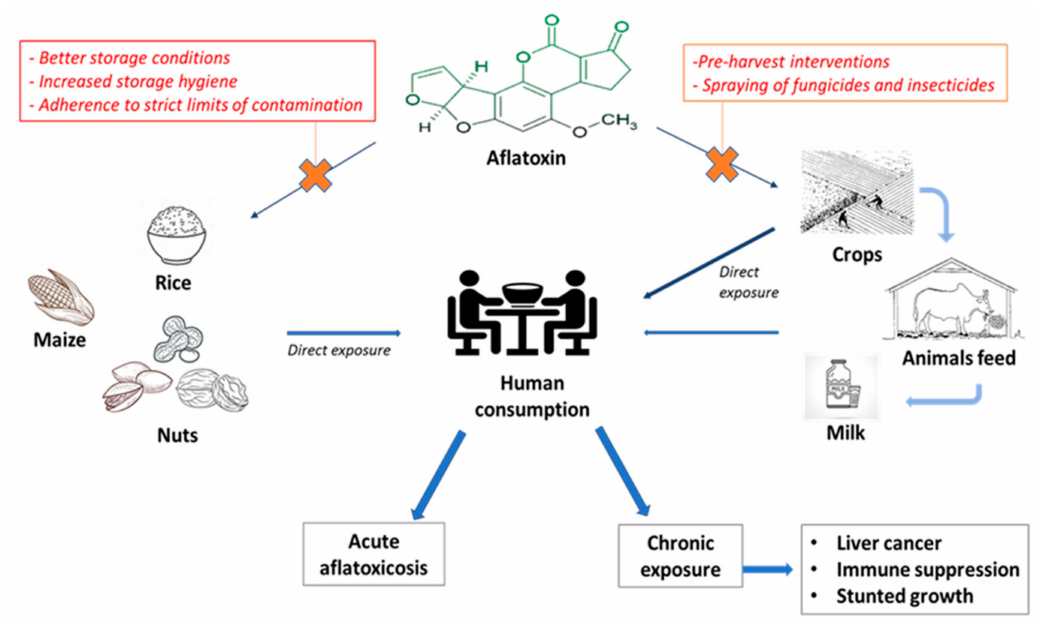
Figure 1. Pontential harms of aflatoxin exposure and possible strategies to prevent aflatoxin contamination of